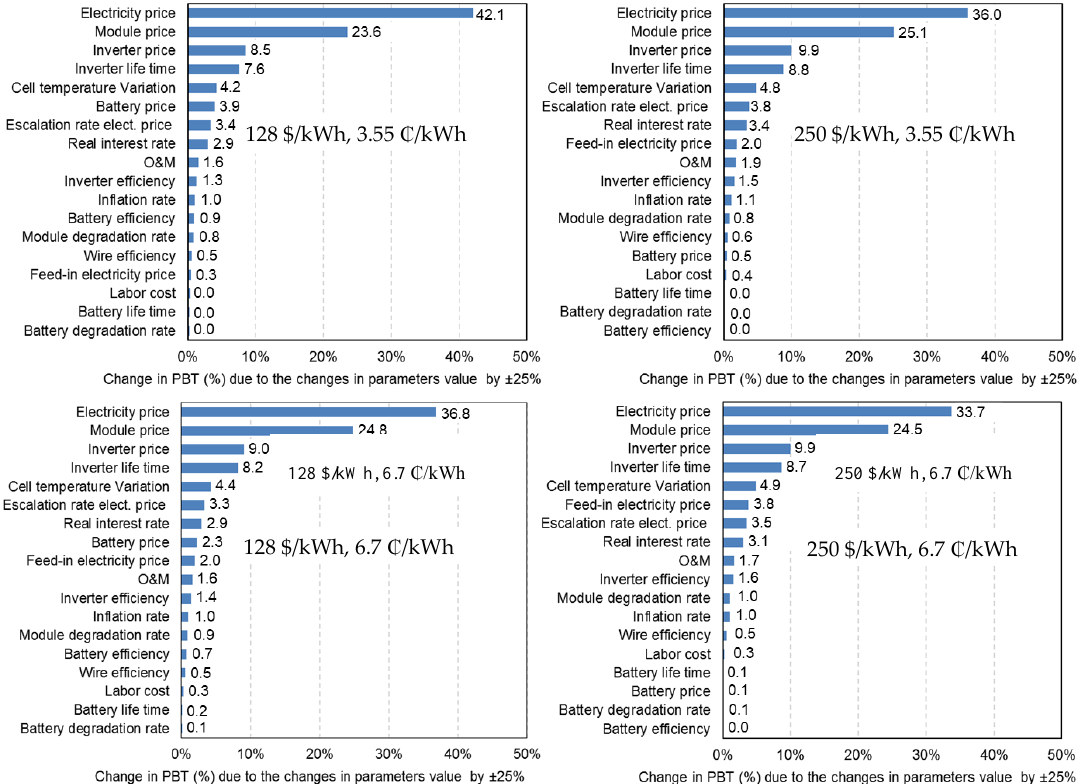
Figure 18. The impact of different factors in term of relative changes in the Payback time of the PV system for battery price 128 $/kWh (left) and 250 $/kWh (right). Feed-in tariff: 3.55 ₵ /kWh (top), and 6.7 ₵ /kWh (bottom). Annual saving target 50%.